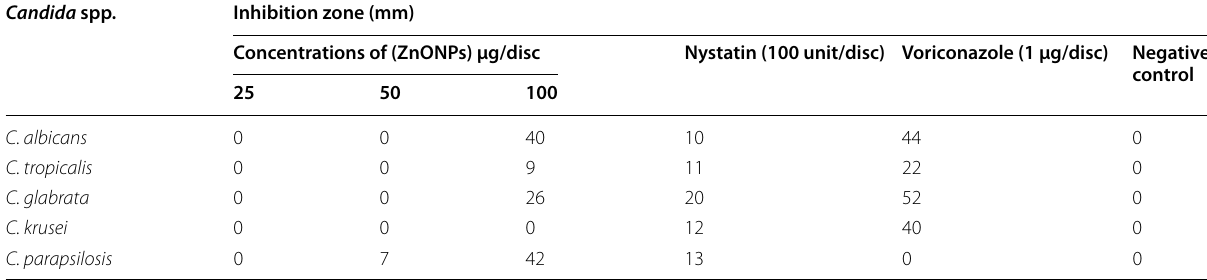
Table 3 Antifungal activity (expressed by inhibitory zone) of different concentrations of ZnONPs in comparison with some commercially available antifungals (Nystatin and Voriconazole) against different Candida species Candida